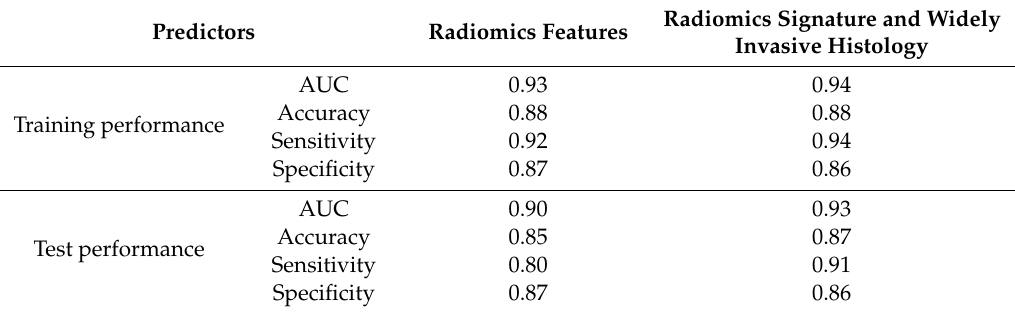
Table 3. Classification results and diagnostic performance of the predicting factors for distant metastasis in FTC patients using support vector machine during five-fold cross-validation.